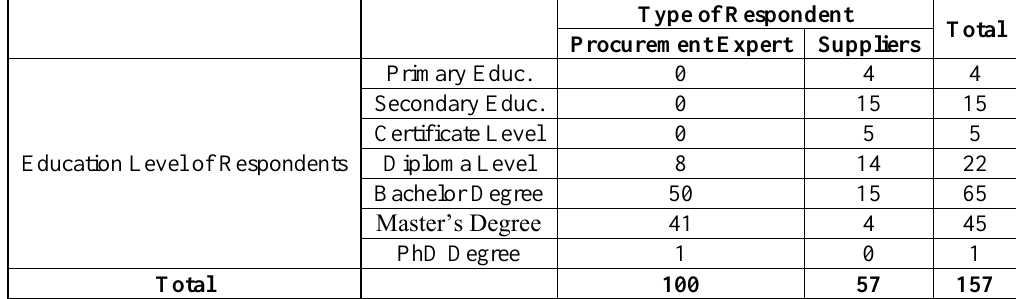
Table 1: Education Level of the Respondents.